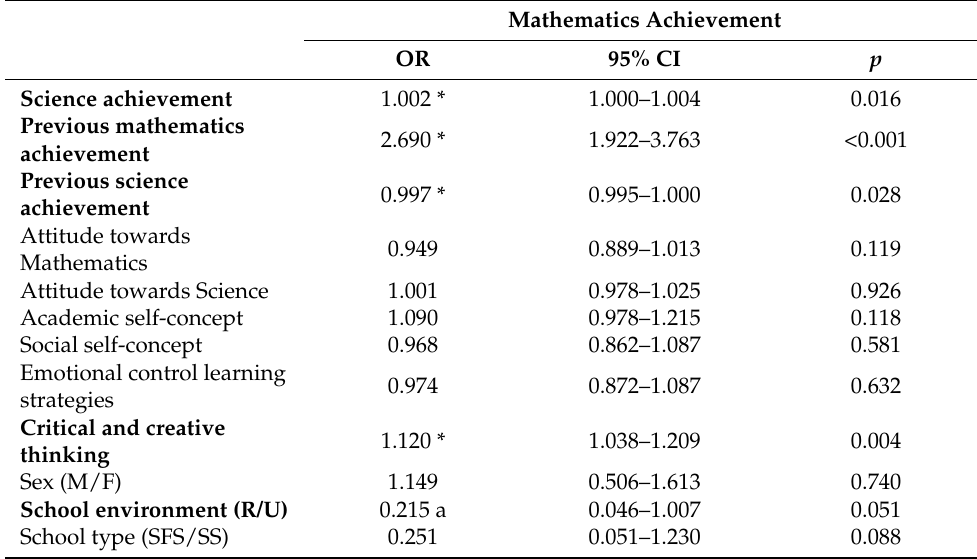
Table 3. Binomial logistic regression based on passing mathematics grades as a reference group.